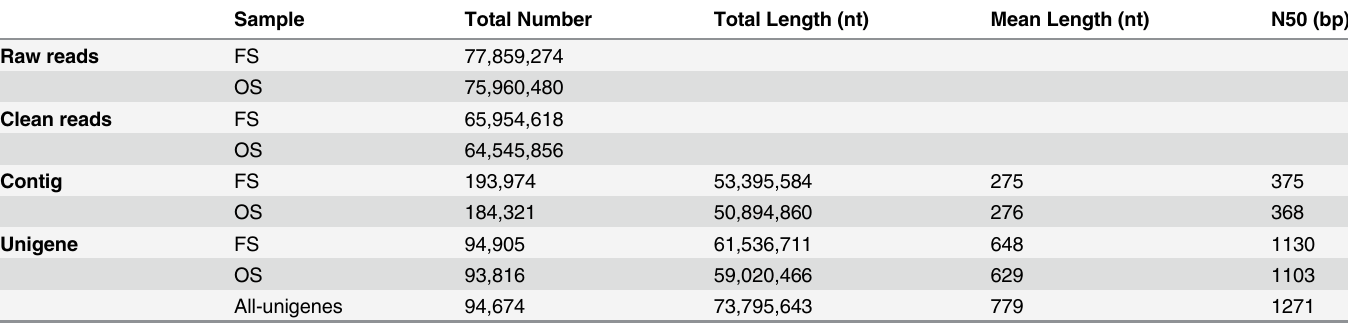
Table 1. A summary of the transcriptome sequencing and assembly results in the FS and OS populations of S . grandis .